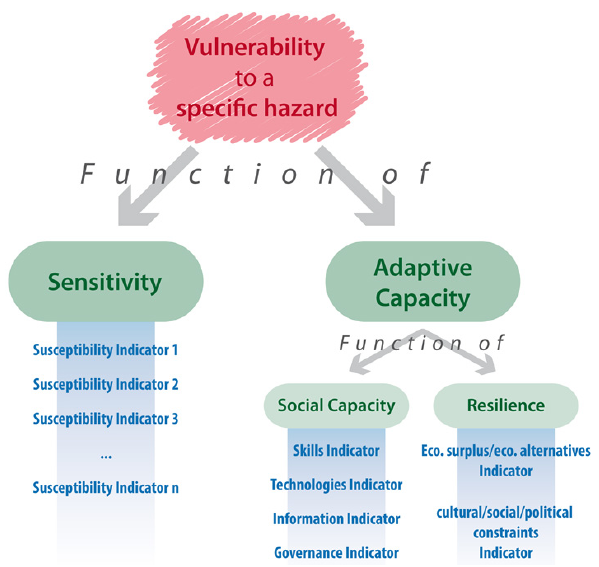
Figure 3. Conceptual model of